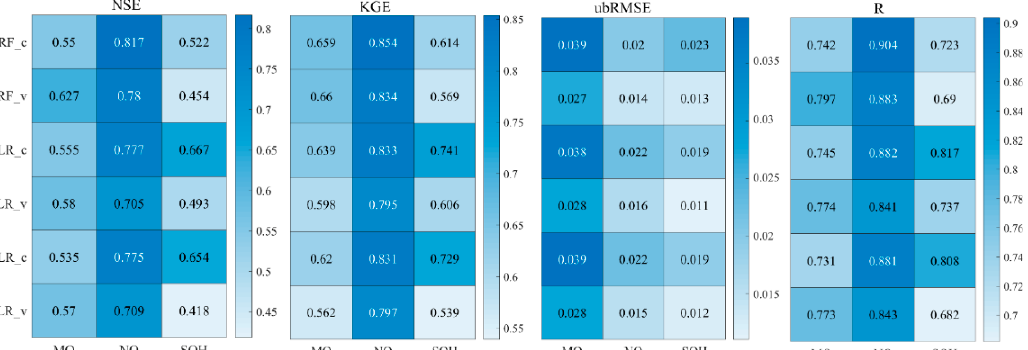
Figure 5. Contrast of the CCI-C SM data (red mark) versus the simulations (blue mark) by the fit models against the in-situ observed SMC data in the MQ, NQ, and SQH areas. RF: random forest; MLR: multiple linear regression; LR: simple linear regression. The diagonal lines represent a 1:1 line. Squares and dots represent the calibration data (70% of the total) and validation data (the remaining 30%), respectively. SM-obs: in-situ SM data; SM-sim/CCI: the data from model fits or the CCI-C dataset.